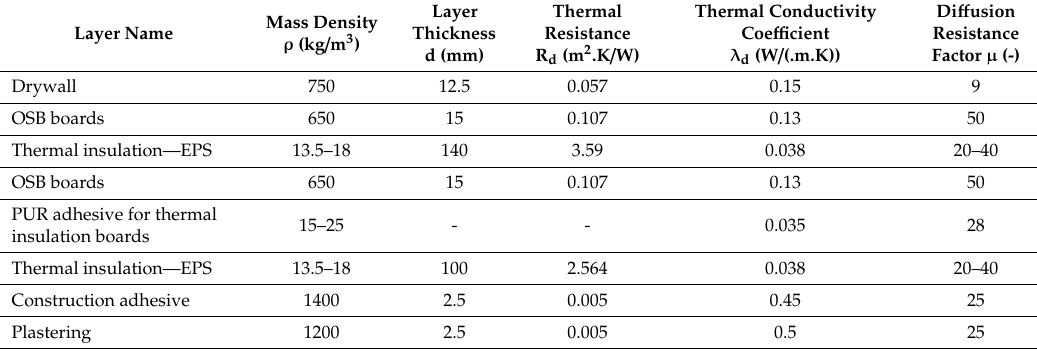
Table 2. Structure of layers from the interior to the exterior—variant